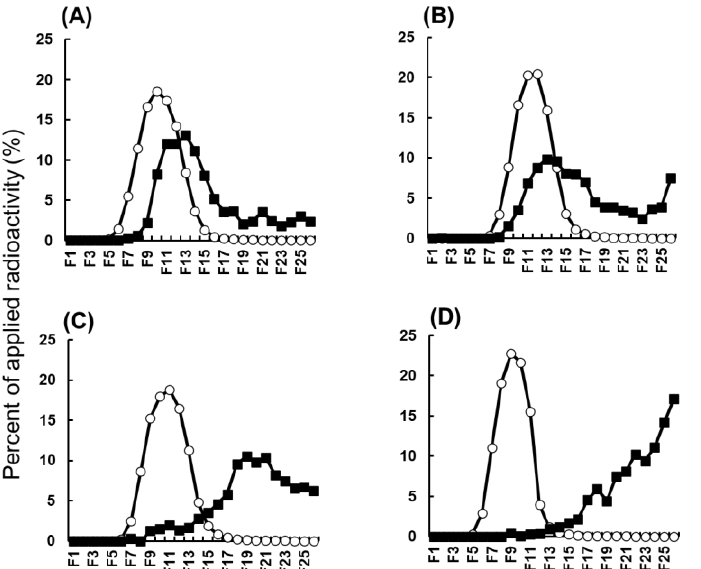
Figure 4. Gel filtration patterns of 111 In-radioacticity in kidney homogenates from mice injected with